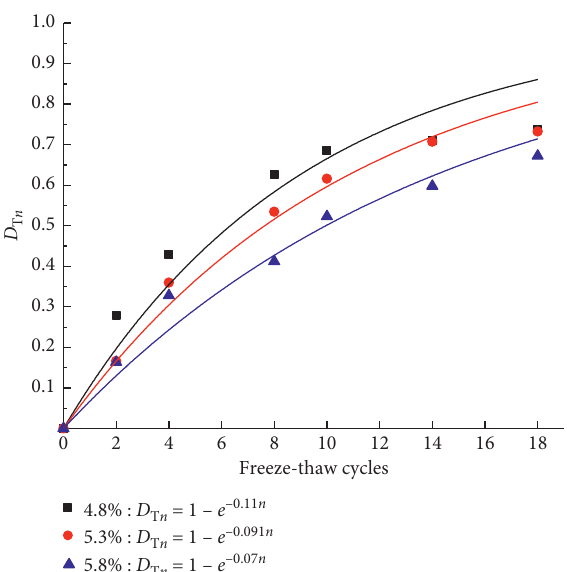
Figure 4: Fitting curves of split degree of freeze-thaw damage vs. freeze-thaw cycle of Z-grade mixtures.